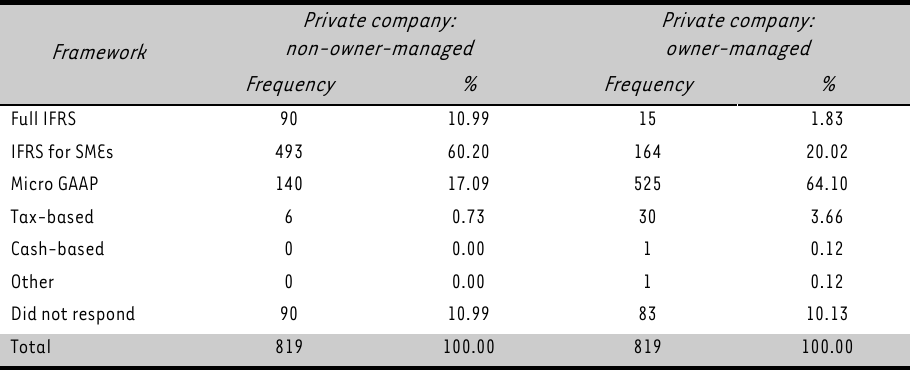
Preferred framework for private companies according to